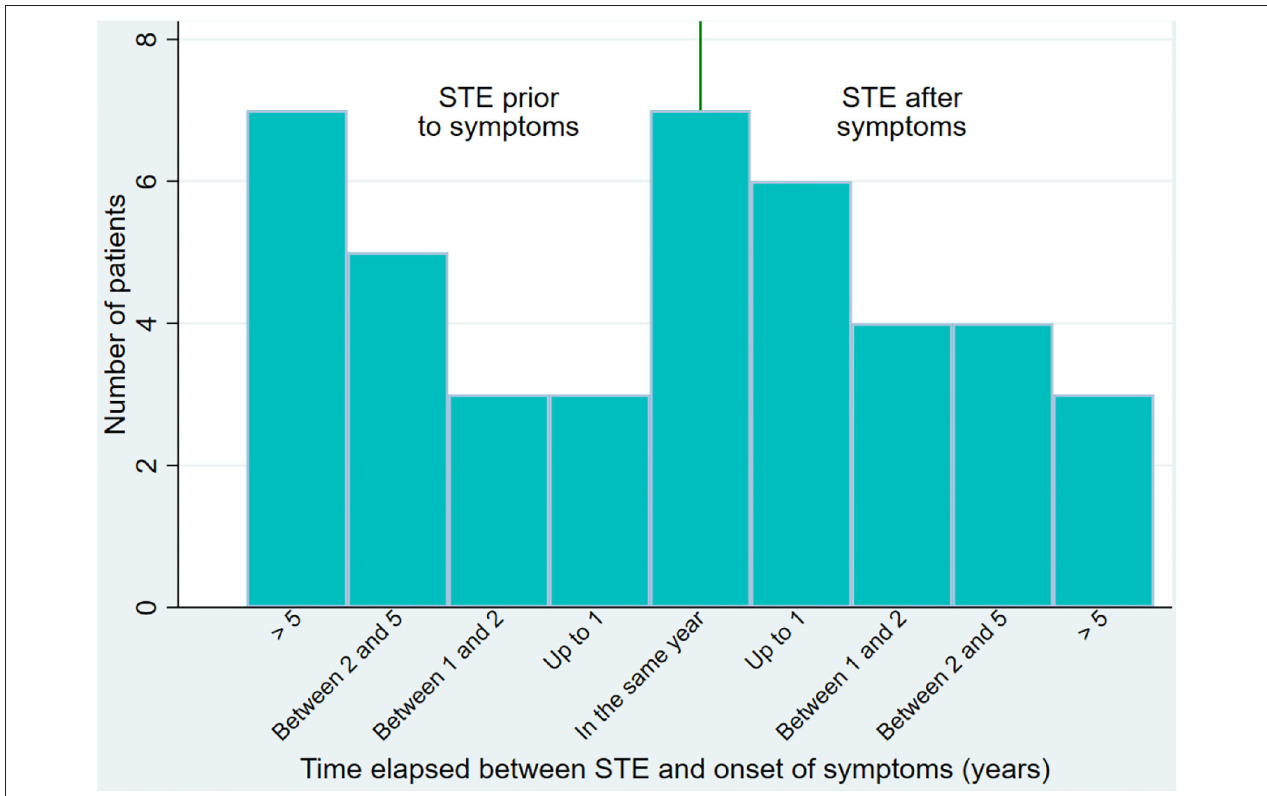
FIGURE 5 | Time elapsed between STE and symptoms of ED. Bar plot of the time elapsed between the STE and the onset of ED symptoms for patients reporting both ( N =